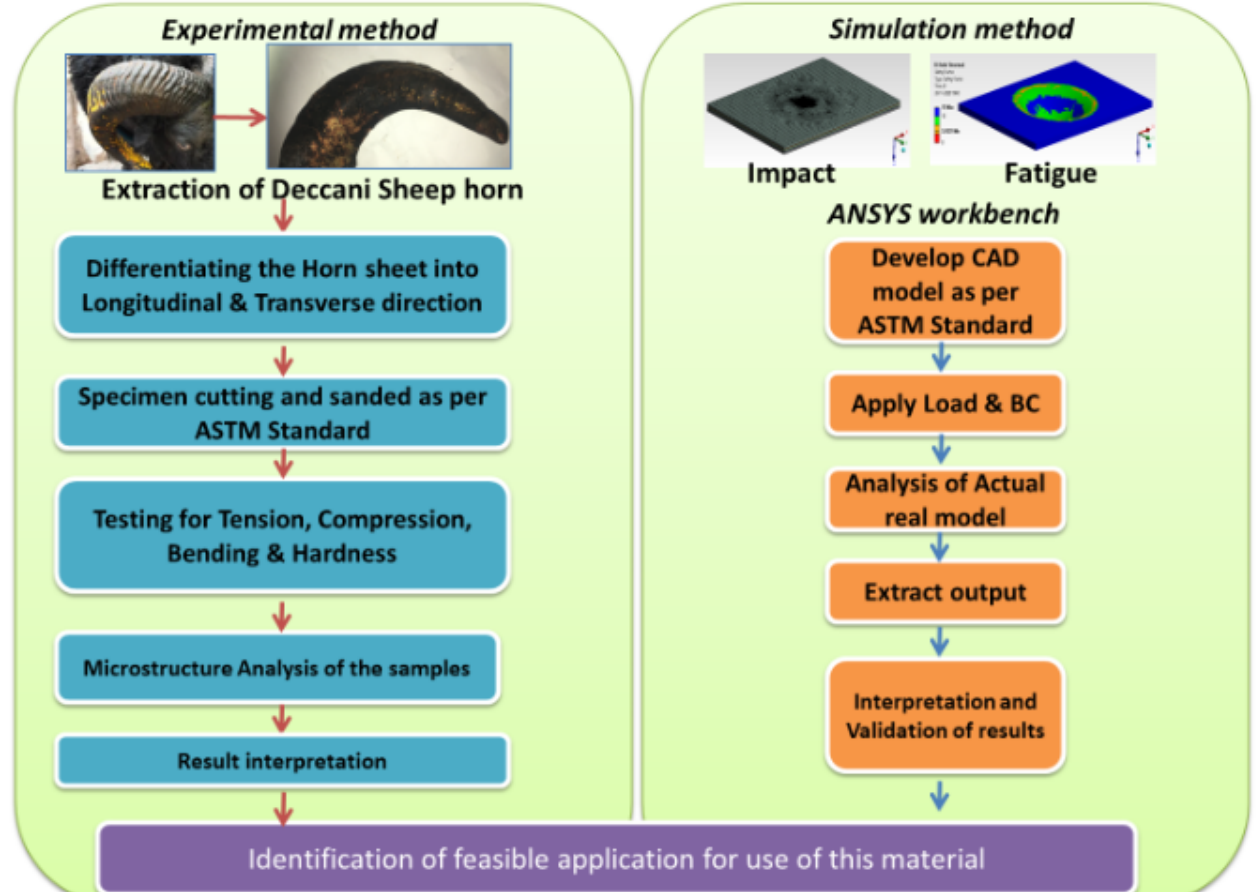
Figure 26. FEA and experimental comparison.